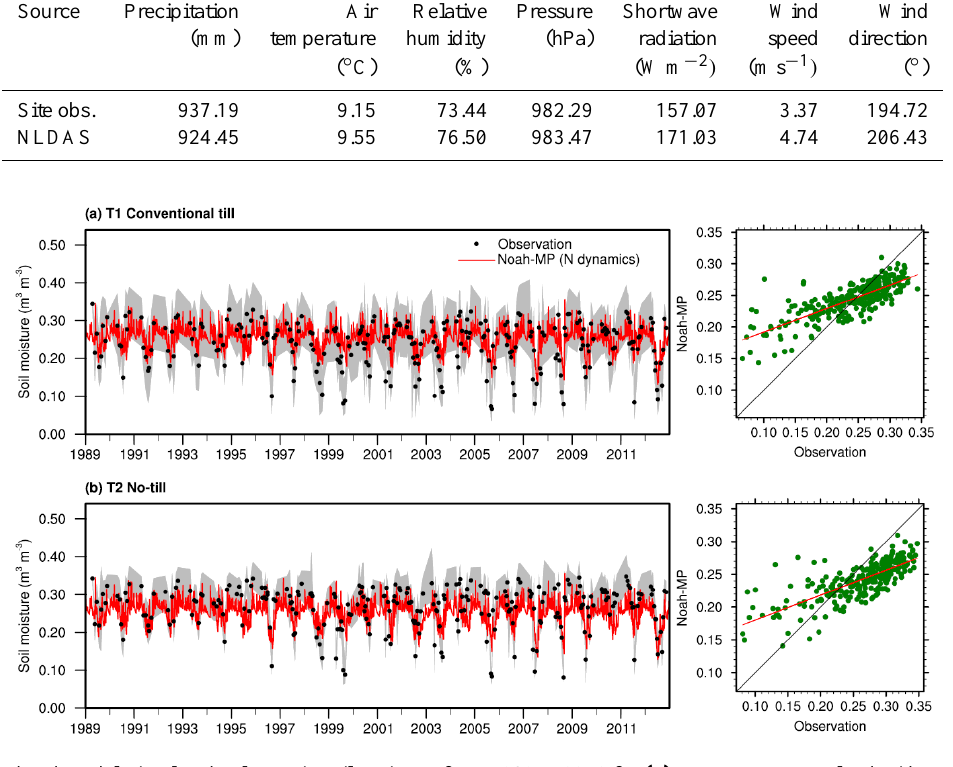
Figure 2. Observed and model-simulated volumetric soil moisture from 1989 to 2012 for (a) treatment 1 – cropland with conventional tillage – and (b) treatment 2: cropland without tillage. The grey shaded area shows the observational ranges from up to six replicates for each